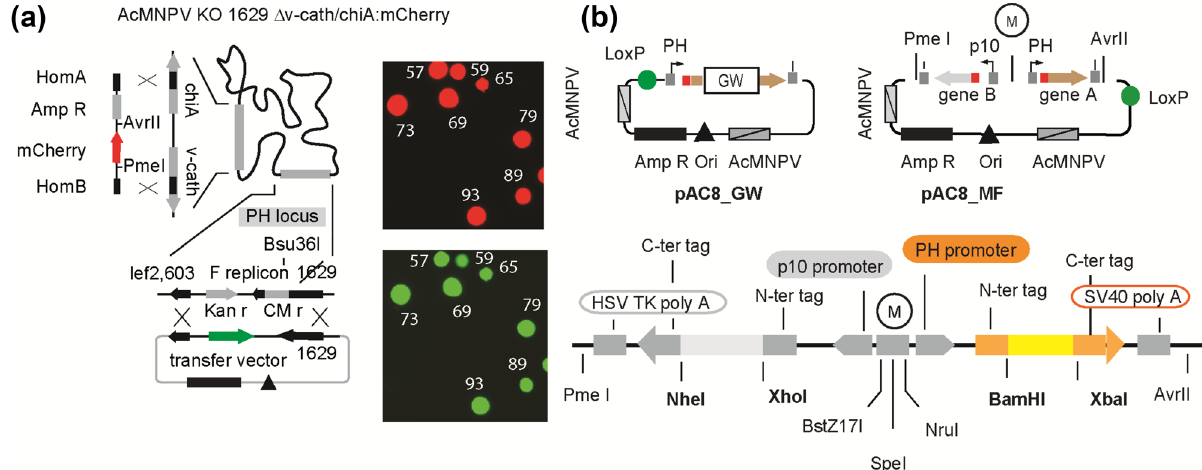
Figure 2. The HR-Bac toolbox components. ( a ) Schematic representation of the AcMNPV BAC10:KO 1629 , Δv-cath/chiA, mCherry bacmid highlighting (i) the modified v-cath/chiA locus where the mCherry-coding sequence was inserted to replace v-cath/chiA ORFs (left panel), and (ii) the inactivated PH locus in which a part of the essential orf1629 and the polyhedrin coding region were replaced by a bacterial replicon (lower panel). Homologous recombination with the transfer vector bearing the ORF of interest (green arrow) restores the function of orf1629 enabling virus replication and replaces the replicon sequence with the sequence(s) of interest. Sf9 cells infected with a recombinant virus generated using AcMNPV BAC10:KO 1629 Δv- cath/ chiA ,mCherry viral DNA and a transfer vector containing the EGFP cDNA observed in a microscope (with a ×20 objective); mCherry and EGFP fluorescence for the same field are shown in the upper and lower panels, respectively. ( b ) Schematic representation of pAC8_GW and pAC8_MF transfer vectors. In pAC8_GW, cDNAs are inserted downstream of the polyhedrin (PH) promoter using a Gateway gene insertion cassette (GW). Proteins are expressed in fusion with an N-terminal affinity tag followed by a protease 3C cleavage site (red square) and with a C-terminal c-myc epitope. In pAC8_MF, cDNAs are expressed under the control of divergent PH and p10 promoters. The Ampicillin resistance gene (Amp R, black rectangles), the lef2,603 and orf1629 homology regions (AcMNPV, grey box) and the replication origin (black triangle) are indicated. A detailed map of the pAC8_MF expression cassette is shown in the lower panel. cDNAs are inserted using the